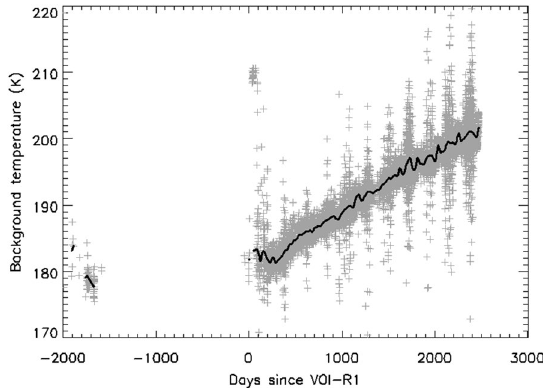
Fig. 1 Temporal variation of background deep space temperature from the launch of Akatsuki to February 2022. Running mean values are shown by a solid